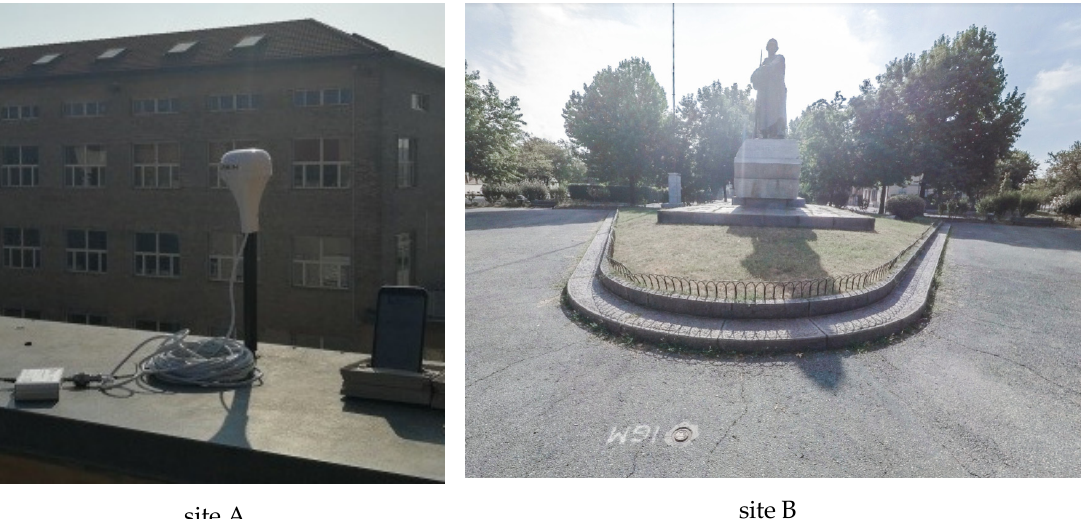
Figure 1. The two test sites: the place that represent the noisy environment (left, site A) and an undisturbed place (right, site